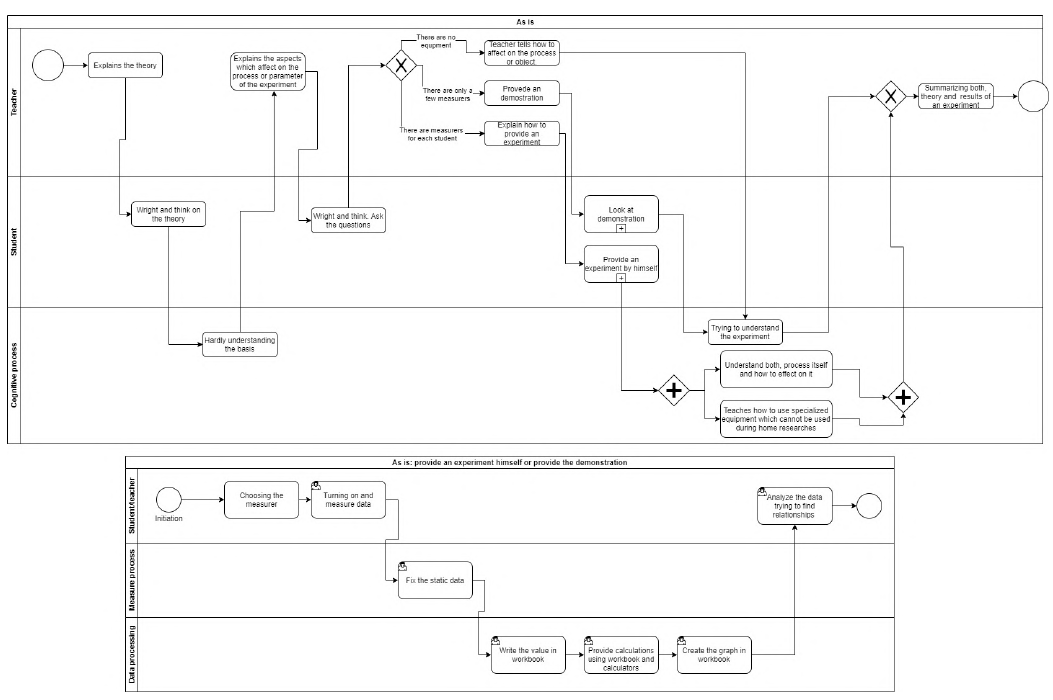
Figure 94: Presentation of paper